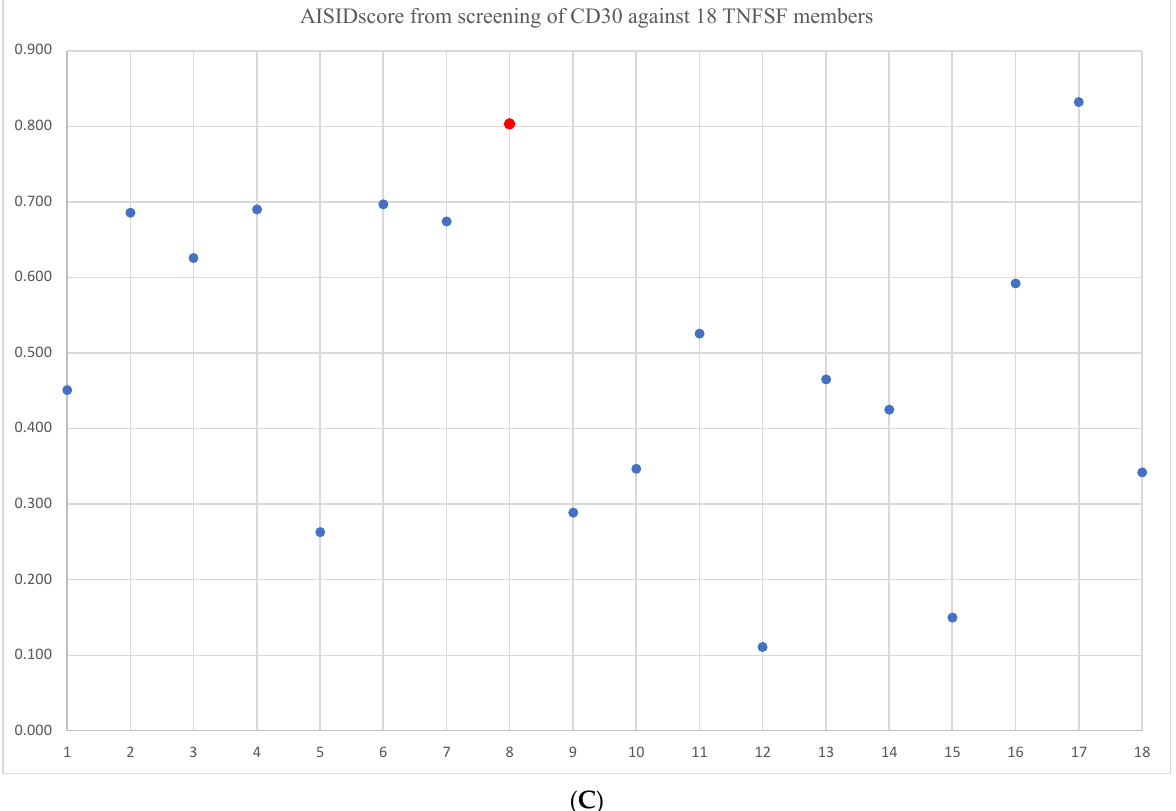
Table 1. AISIDscores of TNF α nanobody against TNFSF superfamily.